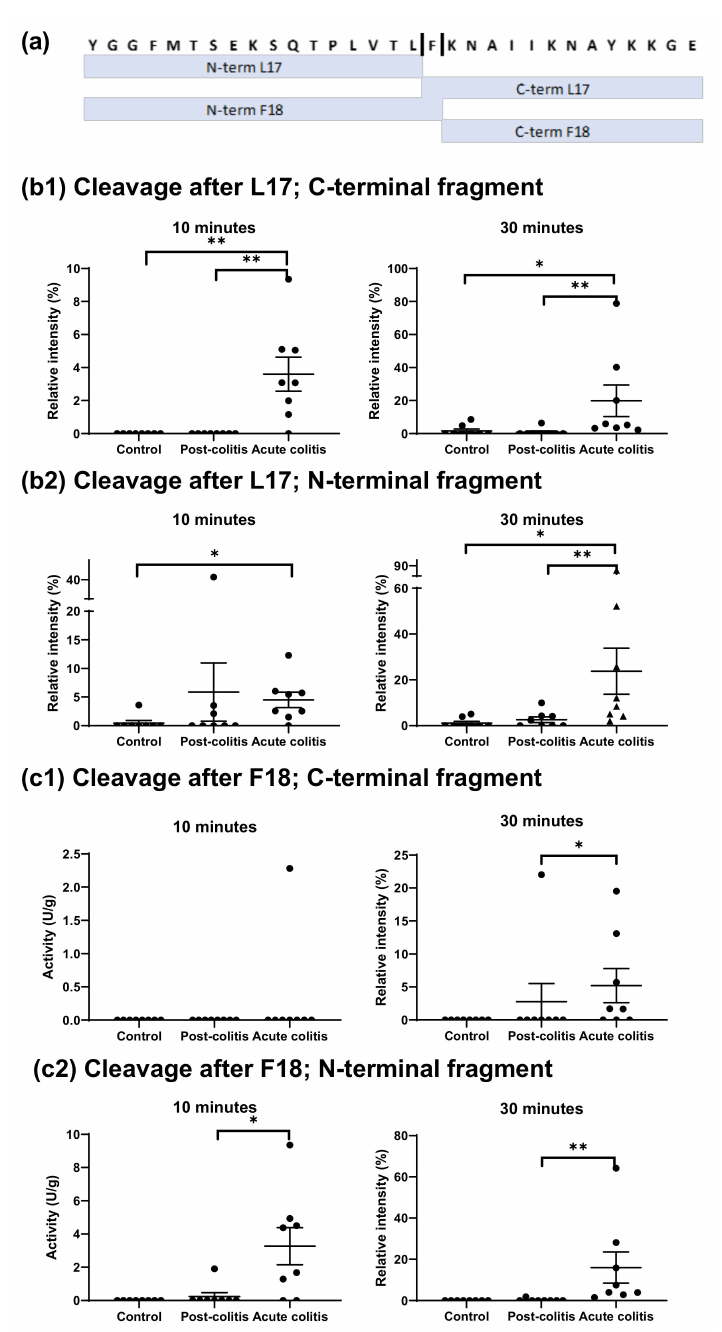
Figure 5. ( a ) Cleavage sites in β -endorphin after incubation with samples from control, post-colitis and acute colitis rats. ( b1 , b2 ) Relative intensities of the C- ( b1 ) and N-terminal ( b2 ) fragment after cleavage at leucine in position 17 after 10 and 30 min of incubation with the colonic samples. The abundance of both fragments is increased after incubation with acute colitis samples compared to control and post-colitis samples. ( c1 , c2 ) Relative intensities of the C- ( c1 ) and N-terminal ( c2 ) fragment after cleavage at phenylalanine in position 18 after 10 and 30 min of incubation with the colonic samples. The abundance of the C-terminal fragment is significantly higher in acute colitis samples compared to controls and the N-terminal fragment is increased in acute colitis samples compared to controls and post-colitis samples. Statistics: Kruskal–Wallis test post hoc Dunnett–Bonferroni. The mean and SEM are shown. n = 8 animals per group * p < 0.05 ** p <